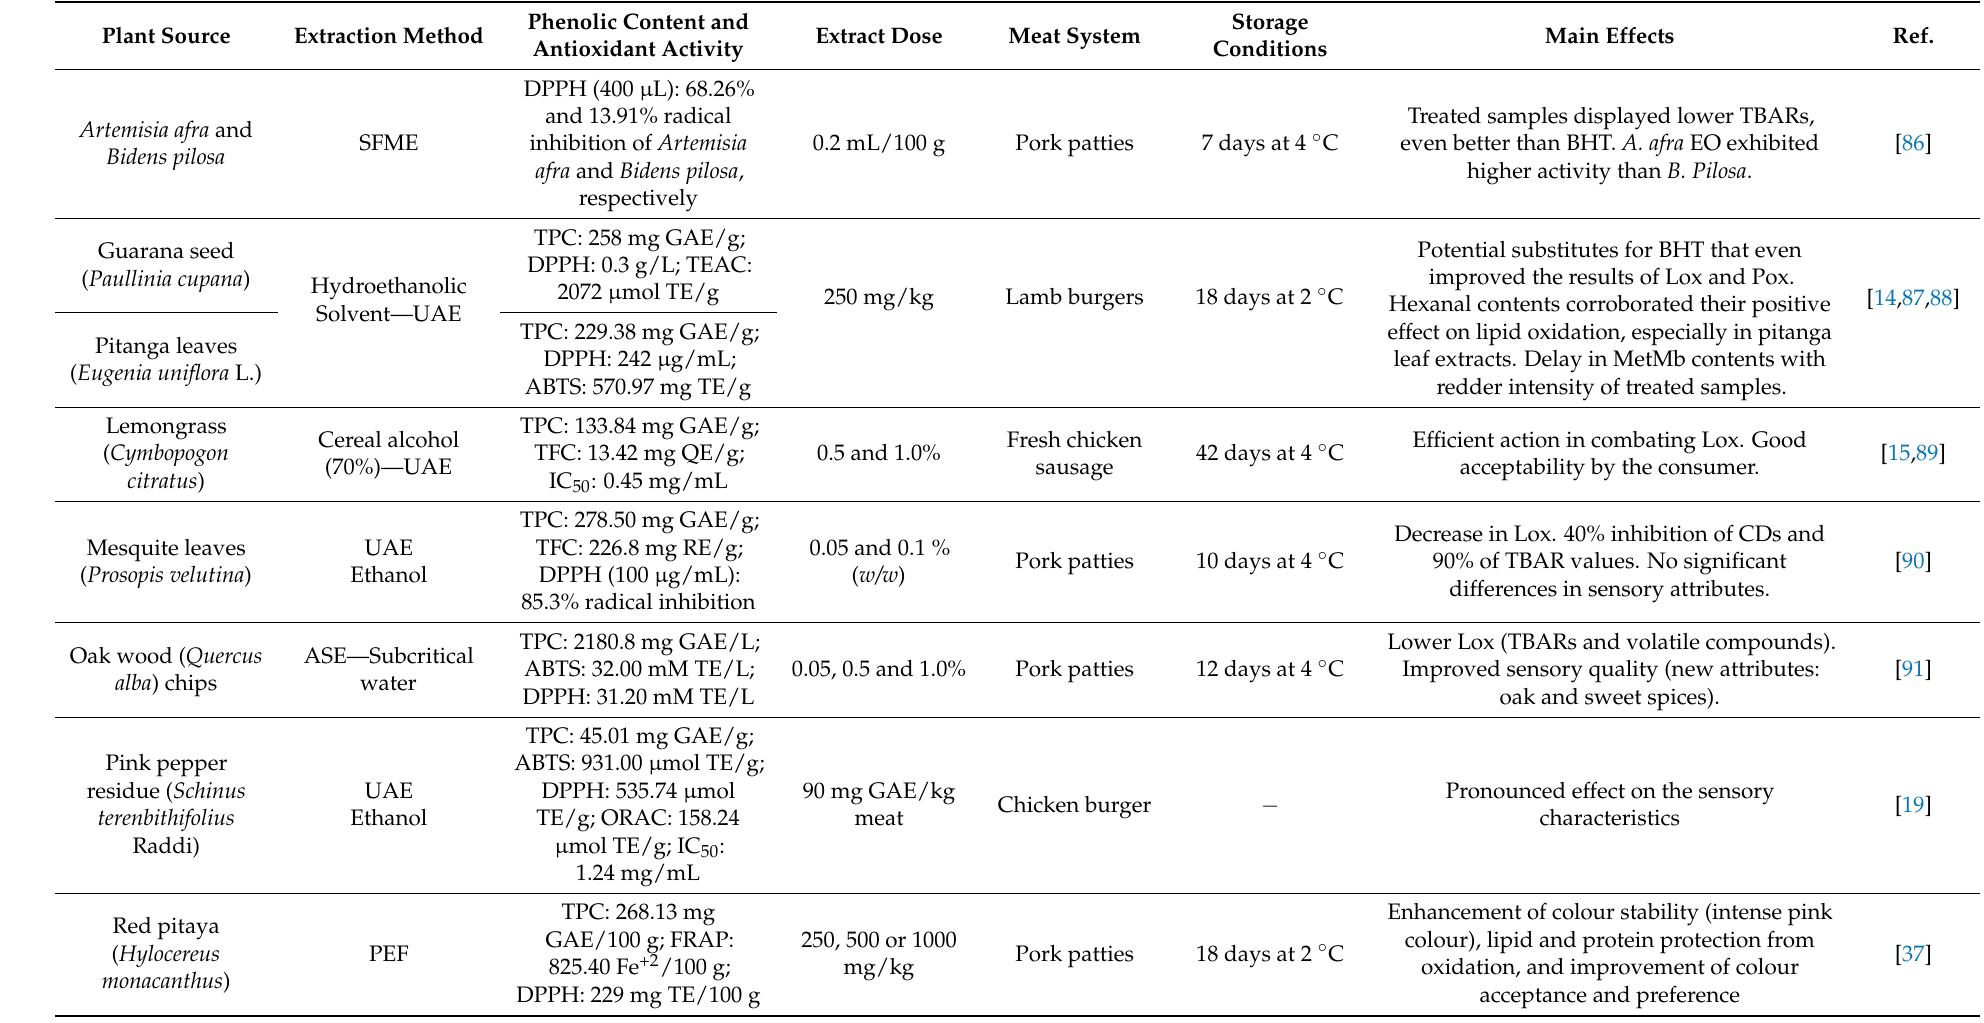
Table 3. Application of natural antioxidants extracted with emerging technologies from plants in meat and meat